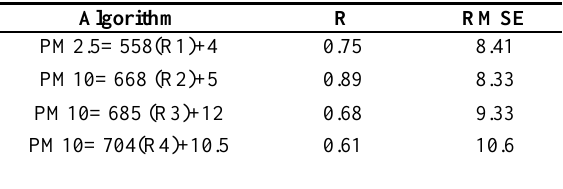
Table 3. The relationship between atmospheric reflectance